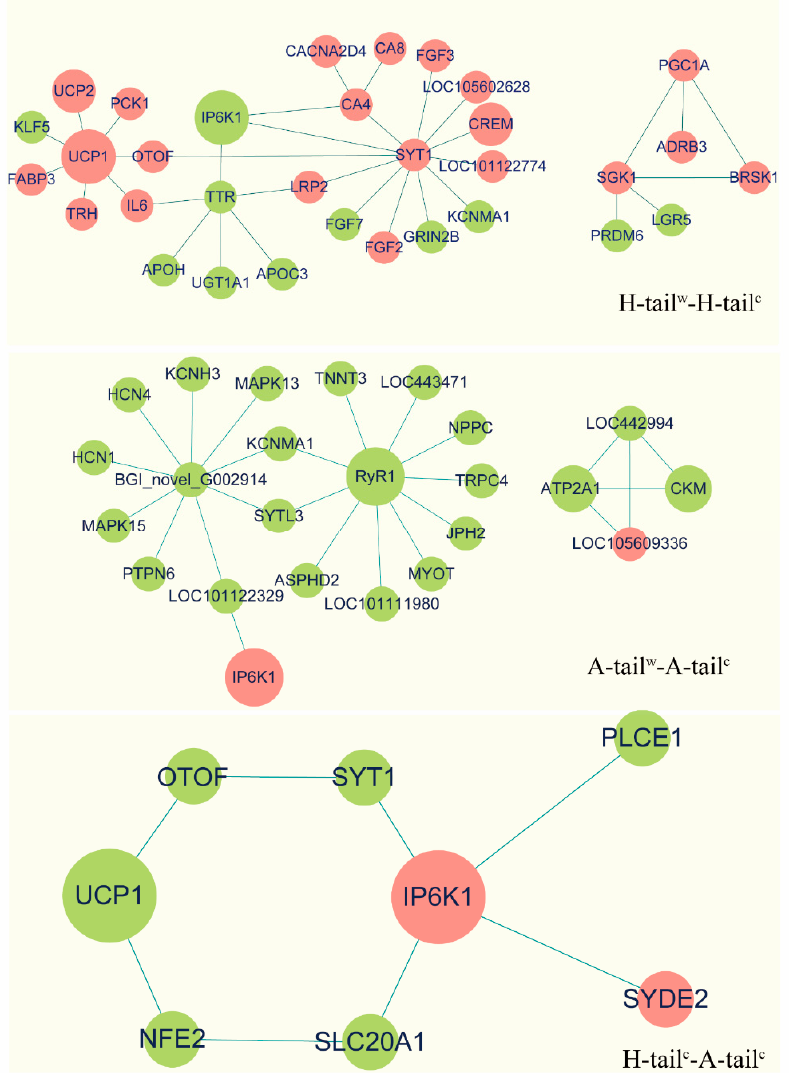
Figure 6. The interaction of proteins between different groups in the tail-fat of cold-exposed Altay and Hu lambs. Red circles represent up-regulation of genes, green circles represent down-regulation of genes. A-tail c : tail-fat tissue of − 5 °C Altay lambs; H-tail c : tail-fat tissue of − 5 °C Altay lambs; A-tail w : tail-fat tissue of 20 °C Altay lambs; H-tail w : tail-fat tissue of 20 °C Hu lambs.